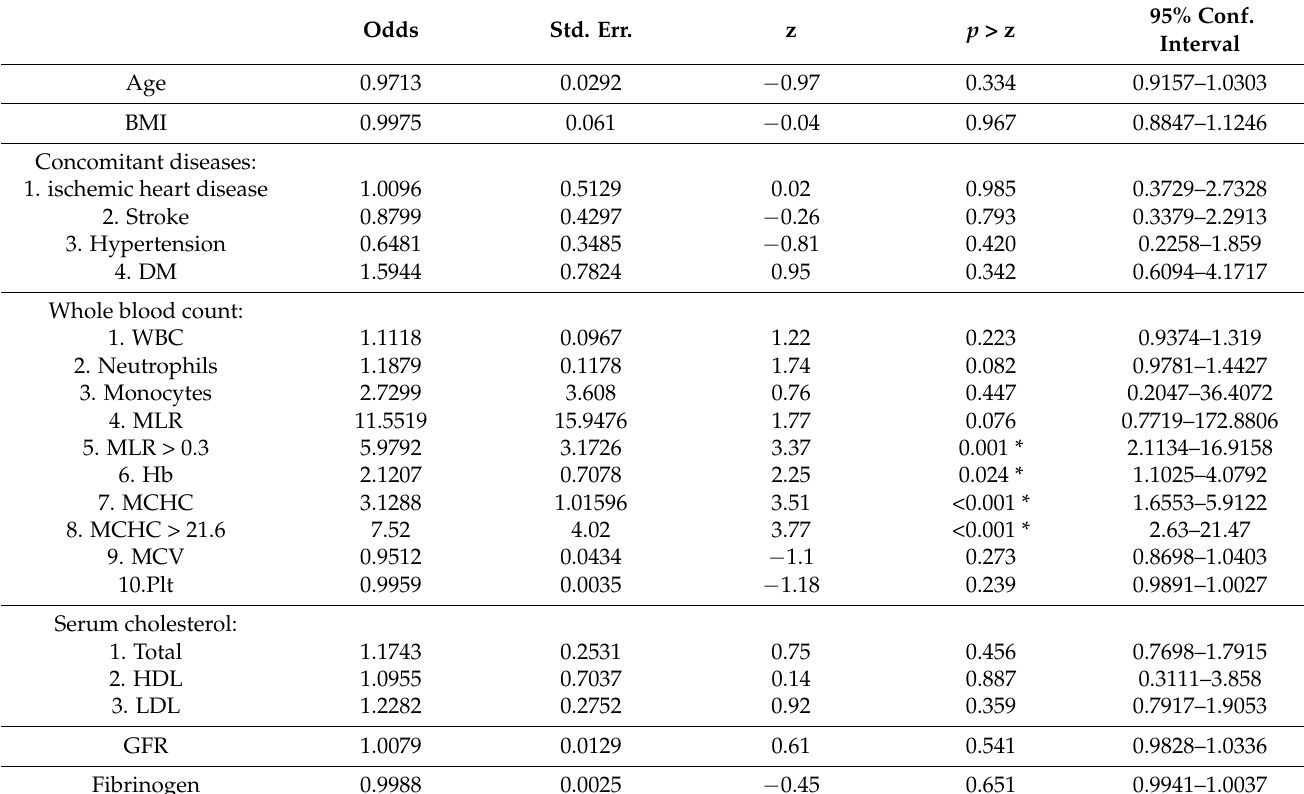
Table 3. Linear regression for collateral carotid disease.